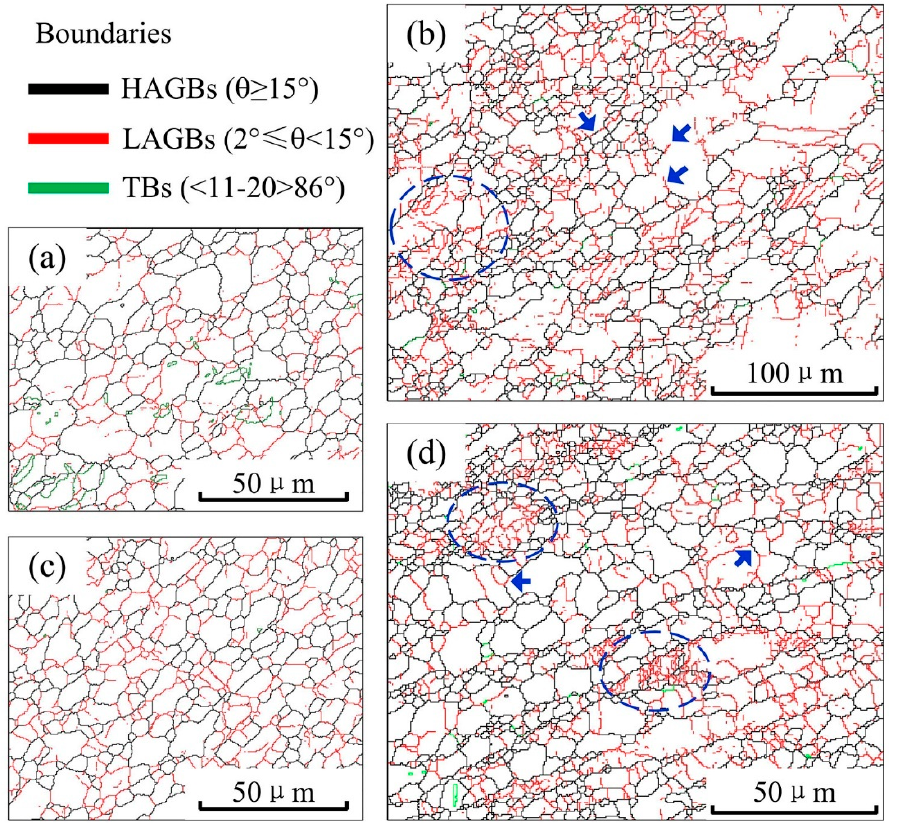
Figure 8. Grain boundary maps of SZ3 and TMAZ at AS: ( a ) SZ3 and ( b ) TMAZ at AS of ZK60/ATZ511 joint; ( c ) SZ3 and ( d ) TMAZ at AS of ATZ511/ZK60 joint. The left of maps ( b , d ) are close to the tool, while the right of maps ( b , d ) are far from the tool.